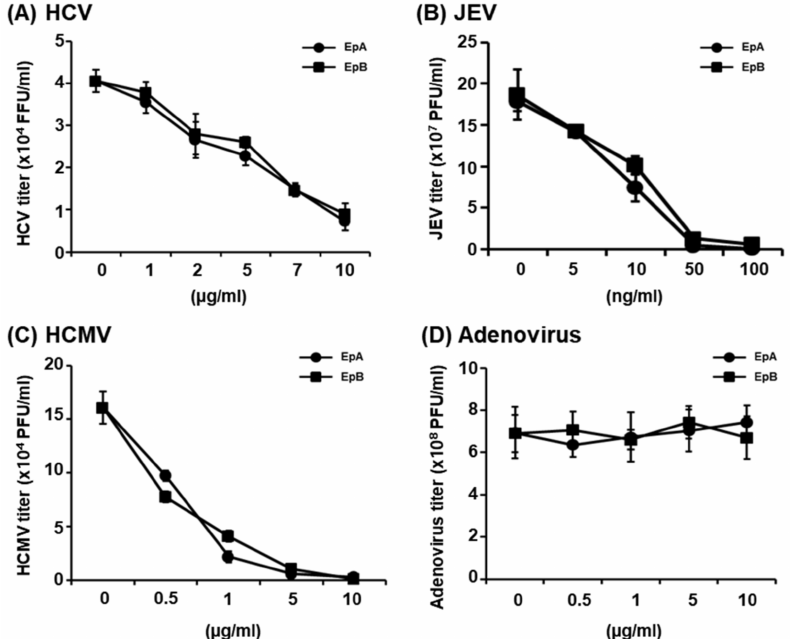
Figure 6. Virucidal activities of ethyl pheophorbides a and b against enveloped viruses. ( A ) HCV, ( B ) JEV, ( C ) HCMV and ( D ) adenovirus were pre-treated with different concentrations of ethyl pheophorbide a (EpA) or b (EpB) and incubated at room temperature for 1 h. Huh 7.5, HFF, BHK21 and 293A cells were infected with mixtures containing serially diluted ( A ) HCV, ( B ) JEV, ( C ) HCMV and ( D ) adenovirus, respectively. Viral titer was determined via immunofluorescence assay (for HCV) or plaque assays (for JEV, HCMV and adenovirus). Experiments were performed in